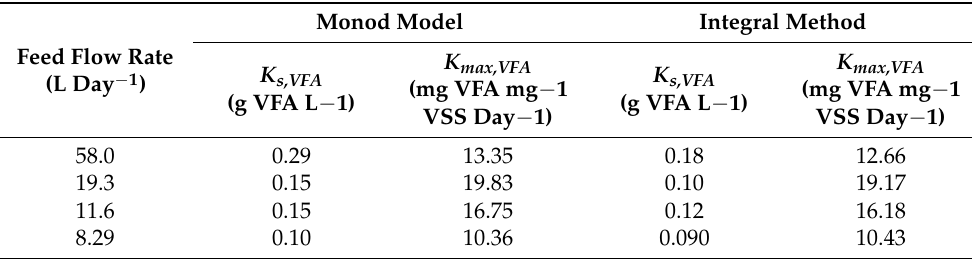
Table 3. Kinetic constant of the Monod model and the integral method for syntrophic acetogenesis.